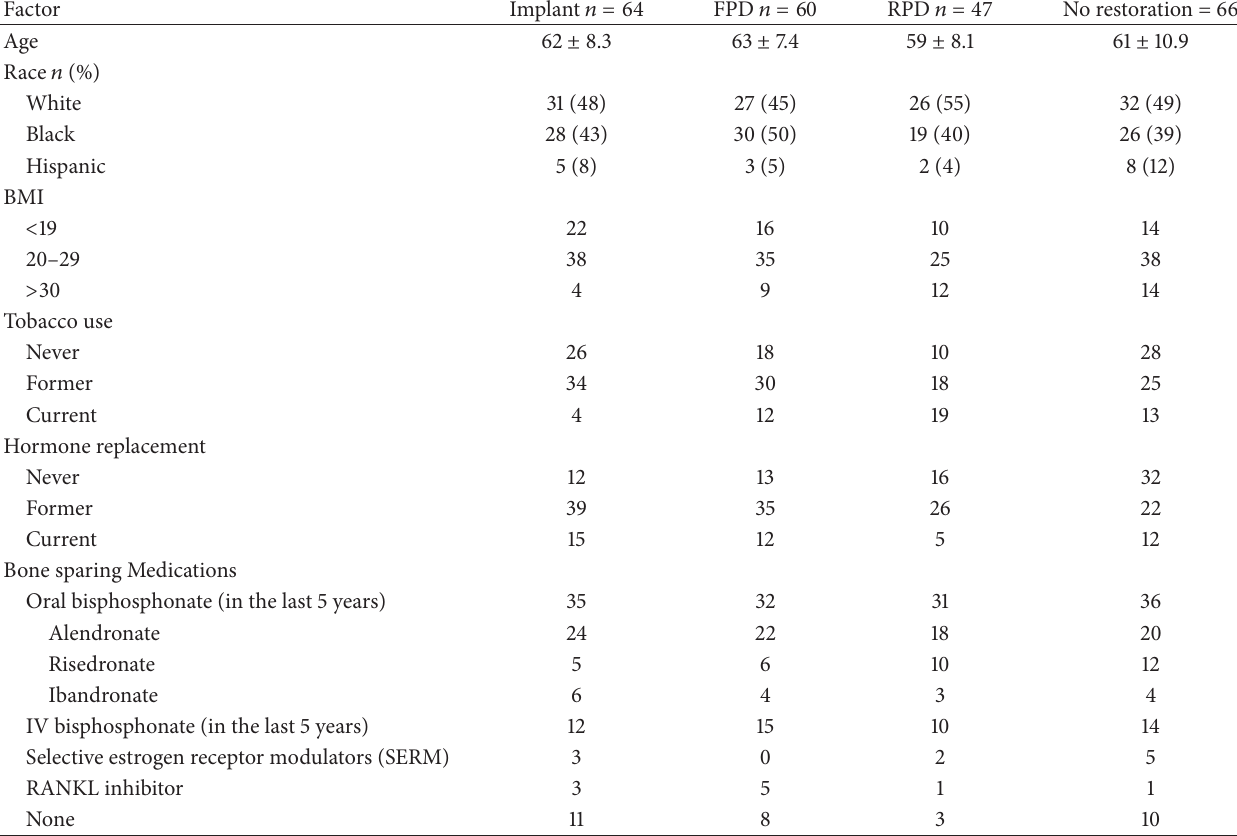
Table 1: Participant demographics. Characteristics of the study population (237 participants).